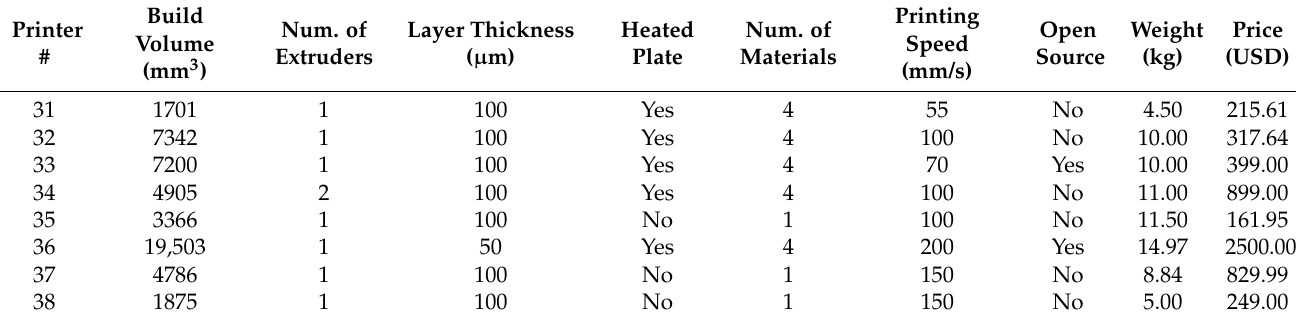
Table 7. Technical specifications/parameters and price of the additional top-rated 3D